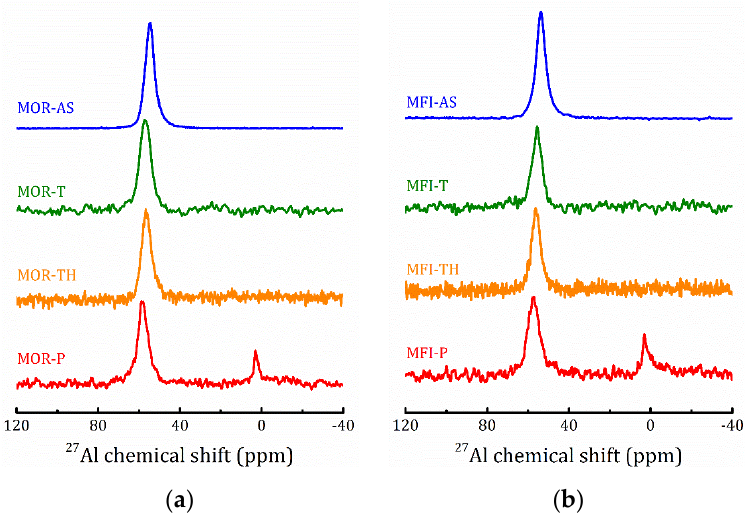
Figure 8. 27 Al MAS NMR spectra of the studied MOR ( a ) and MFI ( b ) samples at all the preparation steps.